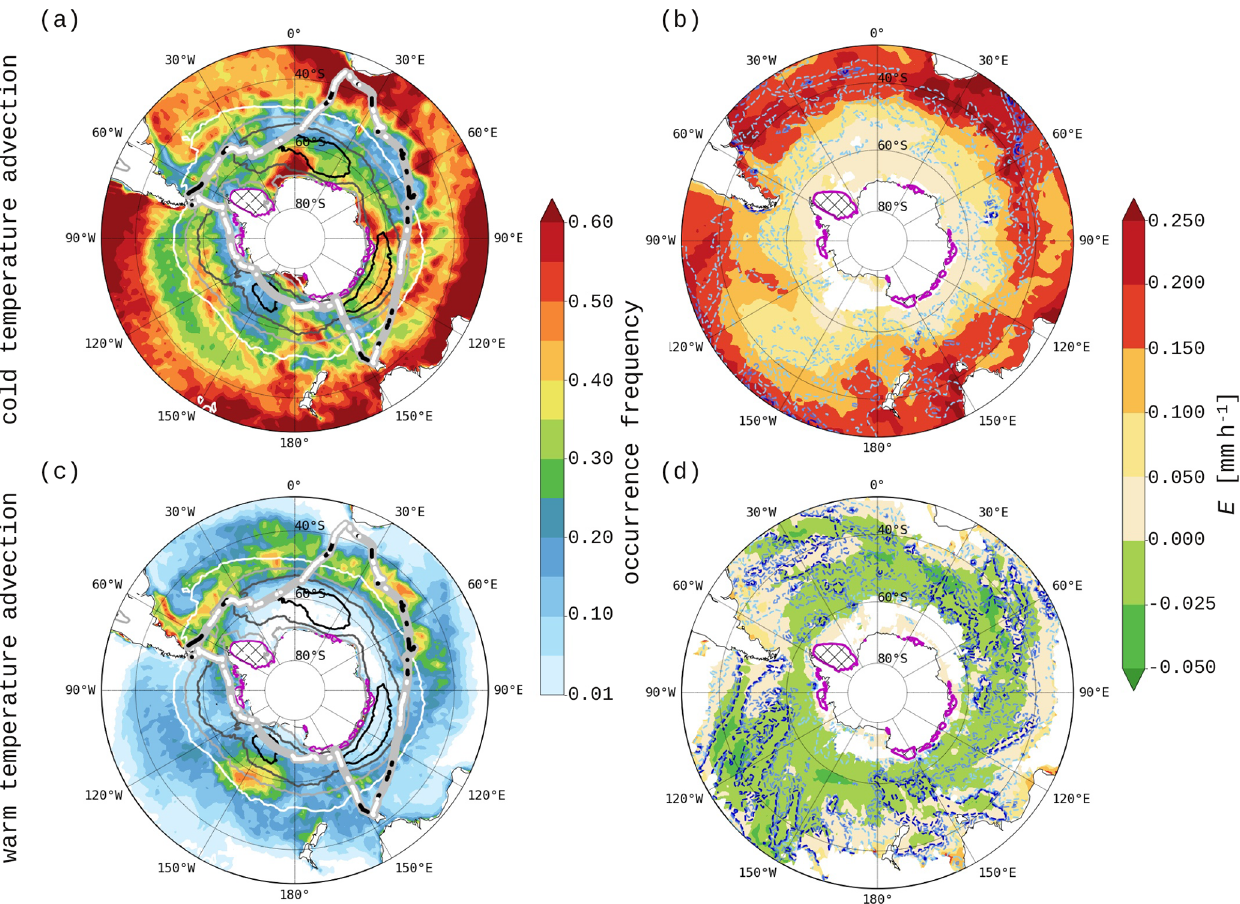
Figure 5. Mean occurrence frequencies of cold and warm temperature advection (a, c) and the associated ocean evaporation (b, d) from December 2016 to March 2017 using ERA-Interim. Contours in panels (a) and (c) show the cyclone frequencies of 10%, 20%, 30% and 40% (from white to black, respectively). Blue dashed lines in panels (b) and (d) show mean surface precipitation in the respective flow category at levels of 0.06, 0.18, 0.24 and 0.3 mmh − 1 (from light to dark blue, respectively). The grey thick line in panels (a) and (c) shows the ACE ship track with the observed occurrences of cold (white points) and warm (black points) temperature advection events during ACE. Land areas and areas covered by at least 50% sea ice are blanked. Additionally, the blanked sea ice areas are hatched and bounded by pink